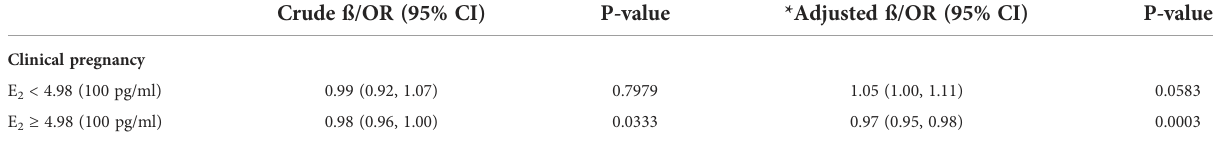
TABLE 4 Threshold effect analysis of serum estradiol level on the day of GnRH-ant initiation on clinical pregnancy using piecewise linear regression. Crude ß/OR (95% CI) P-value *Adjusted ß/OR (95% CI) P-value Clinical